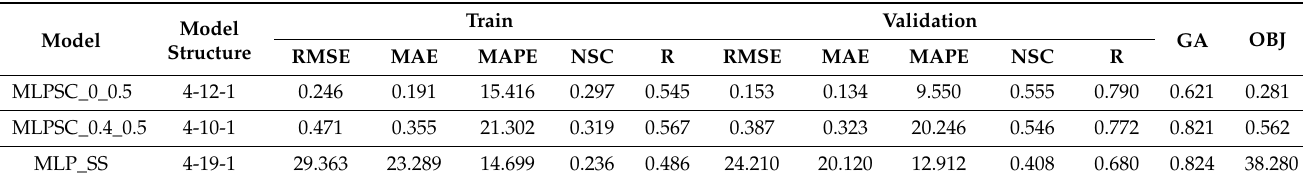
Table 4. Structures and error metrics of the best MLP neural models.